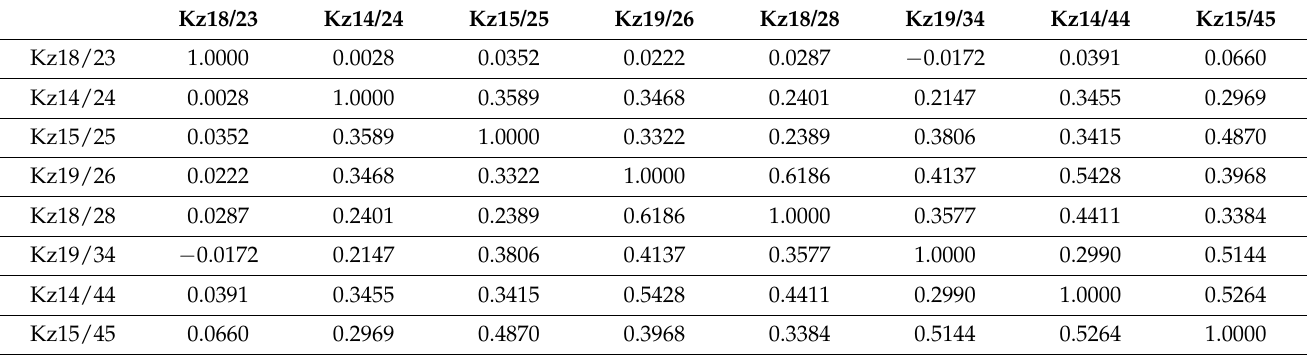
Table 3. YTM return correlation matrix of Kazakhstan’s Sovereign Bonds.